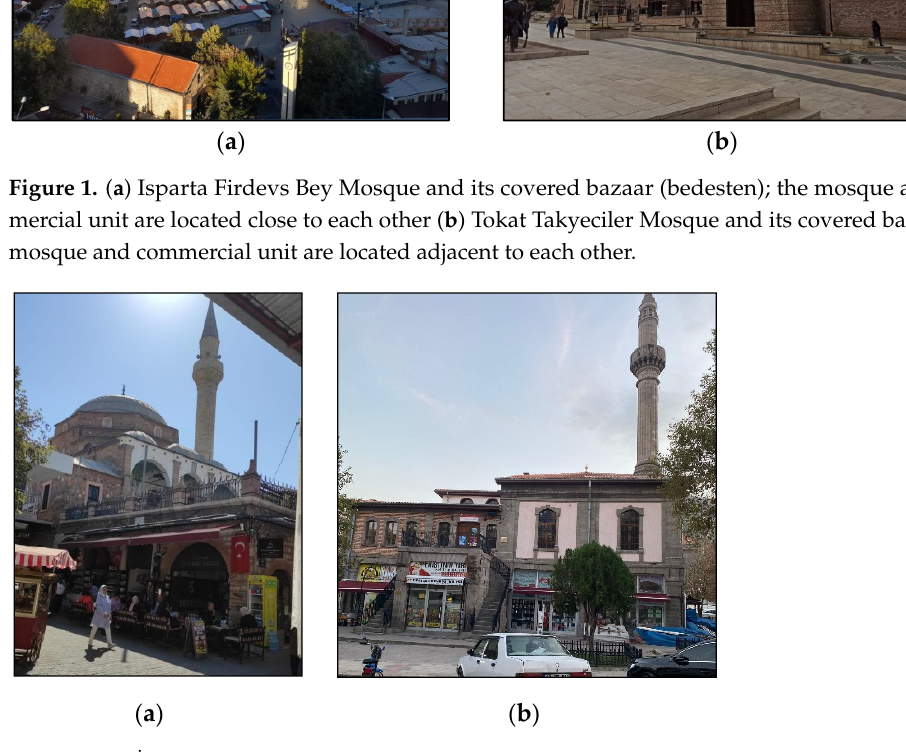
Figure 2. ( a ) ˙Izmir Ba¸sdurak Mosque is located at the lower level of the large-scale commercial unit ( b ) Afyon Yoncaaltı Mosque, where small-scale commercial units are located at the lower